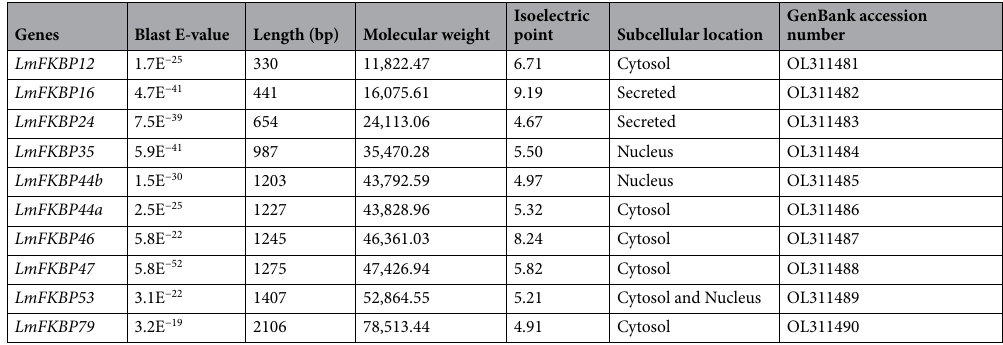
Table 2. Characterization of FKBPs in L. migratoria.